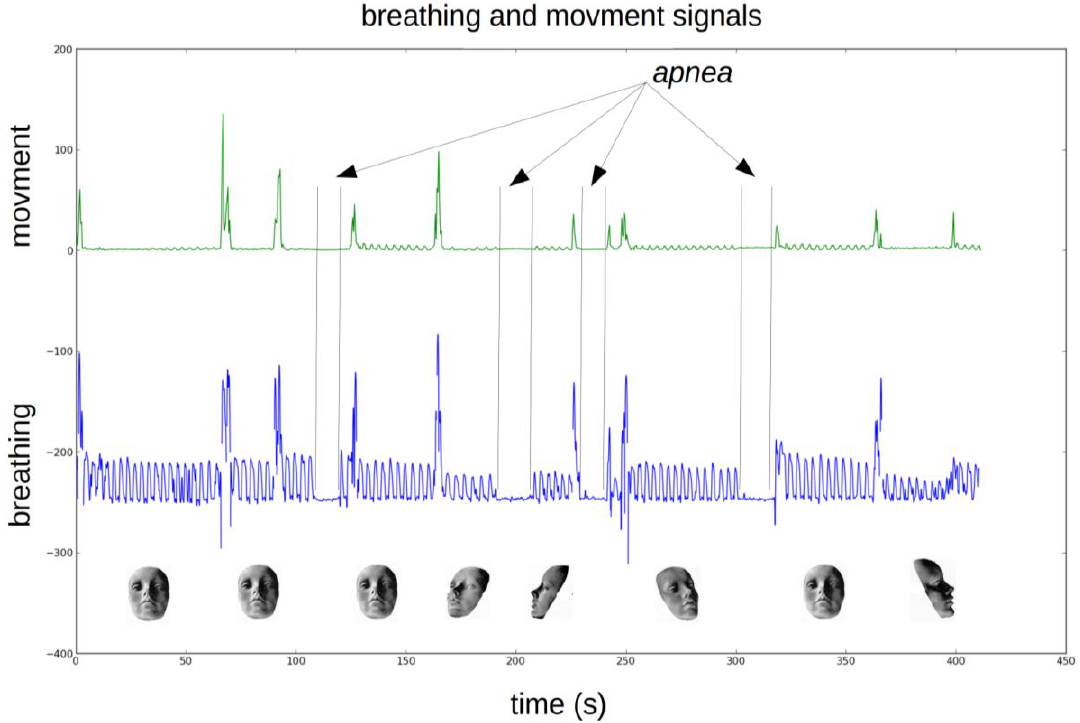
Figure 14. Breathing and movement signals. The movement signal (green; linear scale) increases when the patient changes position. The breathing signal (blue) shows expirations and four apneas. When the movement signal increases the breathing signal is